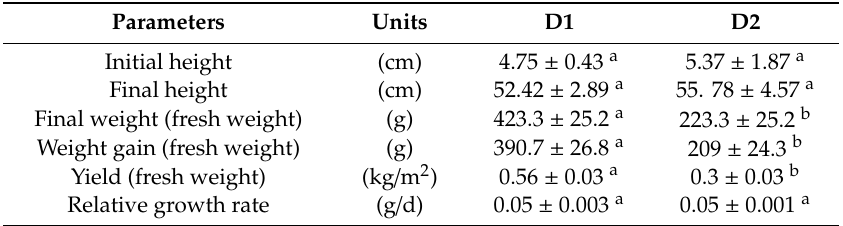
Table 3. Plant growth parameters in the aquaponic system. All values are mean ± standard deviation obtained from three replicates. Di ff erent superscript letters (a, b) within a row indicate statistically di ff erent mean values at p < 0.05; a > b ( t -test).